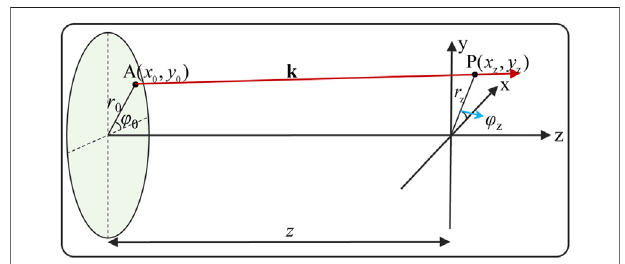
FIGURE 1 | Schematic diagram of a light ray ’ s propagation for a vortex beam in the homogeneous medium.